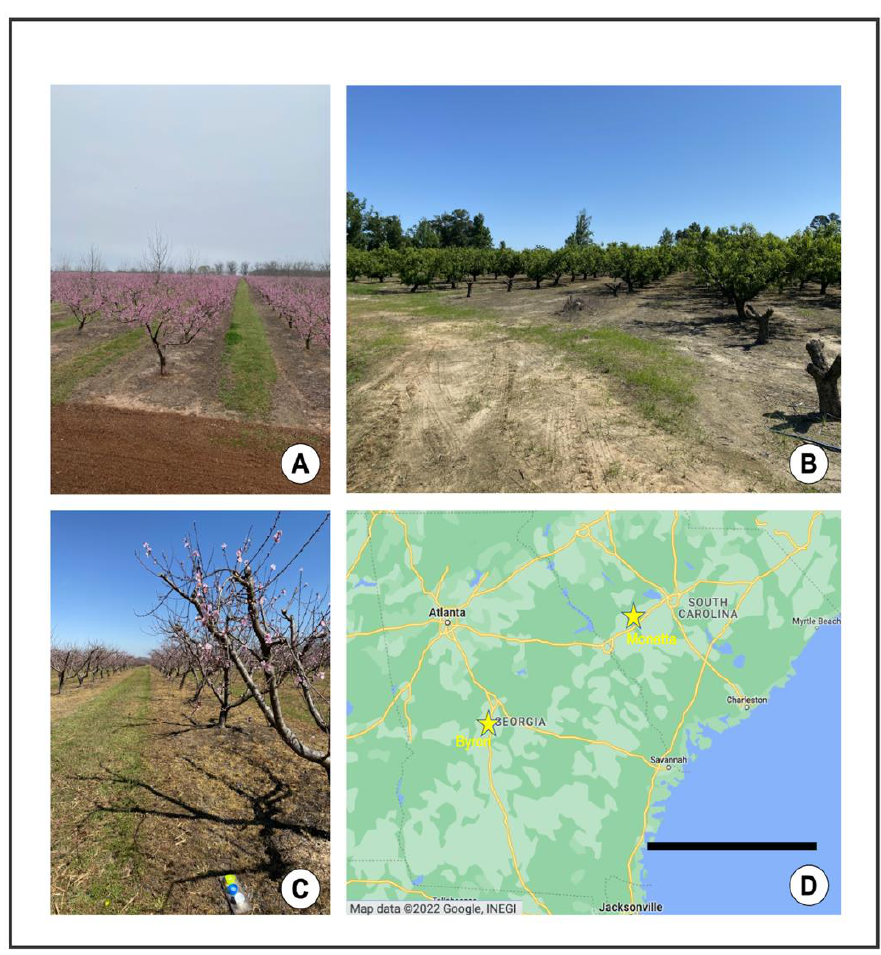
Figure 2. Field sites. ( A ) Commercial peach farm (high input), Byron, GA, 3/9/2021. ( B ) Organic peach farm (low input), Monetta, SC, 5/13/2021. ( C ) Commercial peach farm, Byron, GA, 3/16/2021. ( D ) Locations of field sites in Southeastern U.S. Map data © 2022 Google, INEGI (Google Maps) [20] Scale bar = 240 km.